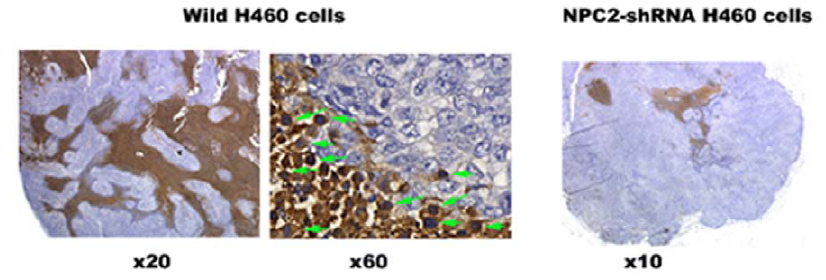
Figure 5. TUNEL assay in xenografts NPC2 protein-rich and-depleted cells. Apoptotic ell death was seen between papillary structures (brown colored areas) in wild H460 cells. The transition from epithelial cells (blue colored cells) to apoptotic cells (brown colored cells) was seen in the outer border of epithelium (middle panel). NPC2 protein-depleted H460 cells showed only small areas of apoptotic cell death.